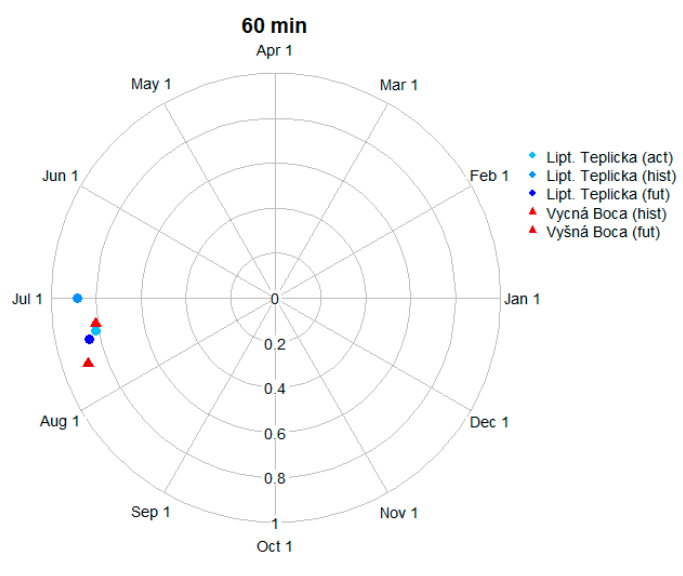
Figure 7. Burn´s diagram for a rainfall duration of 60 min for the Liptovsk á Tepliˇcka and Vyšn á Boca climatological